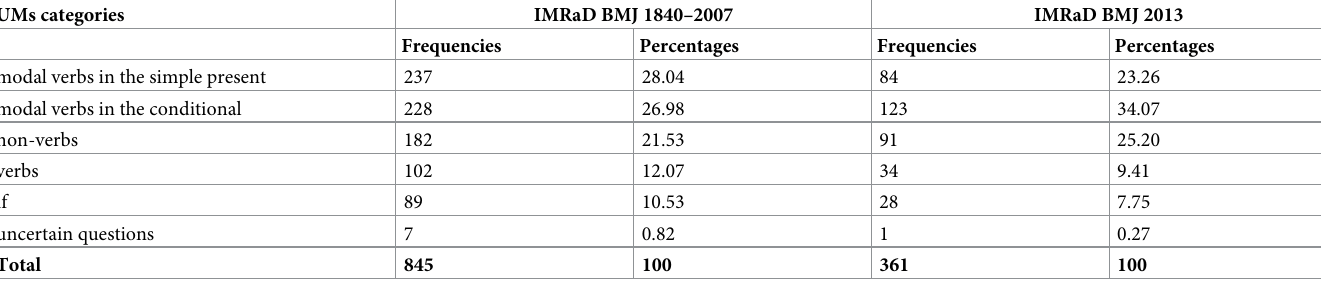
Table 12. Frequencies and percentages of UMs in IMRaD BMJ 1840–2007 articles and in IMRaD BMJ 2013 articles.